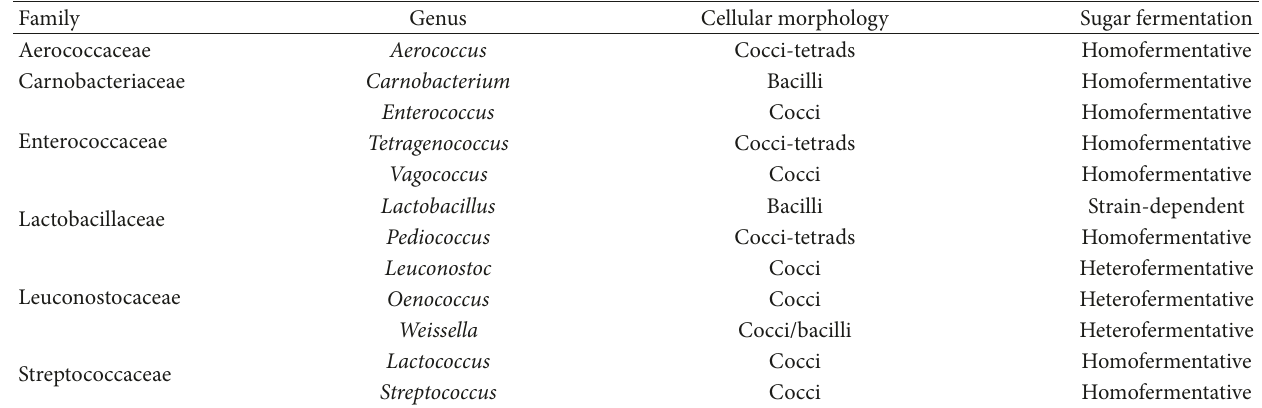
Table 1: Families and genera of LAB.